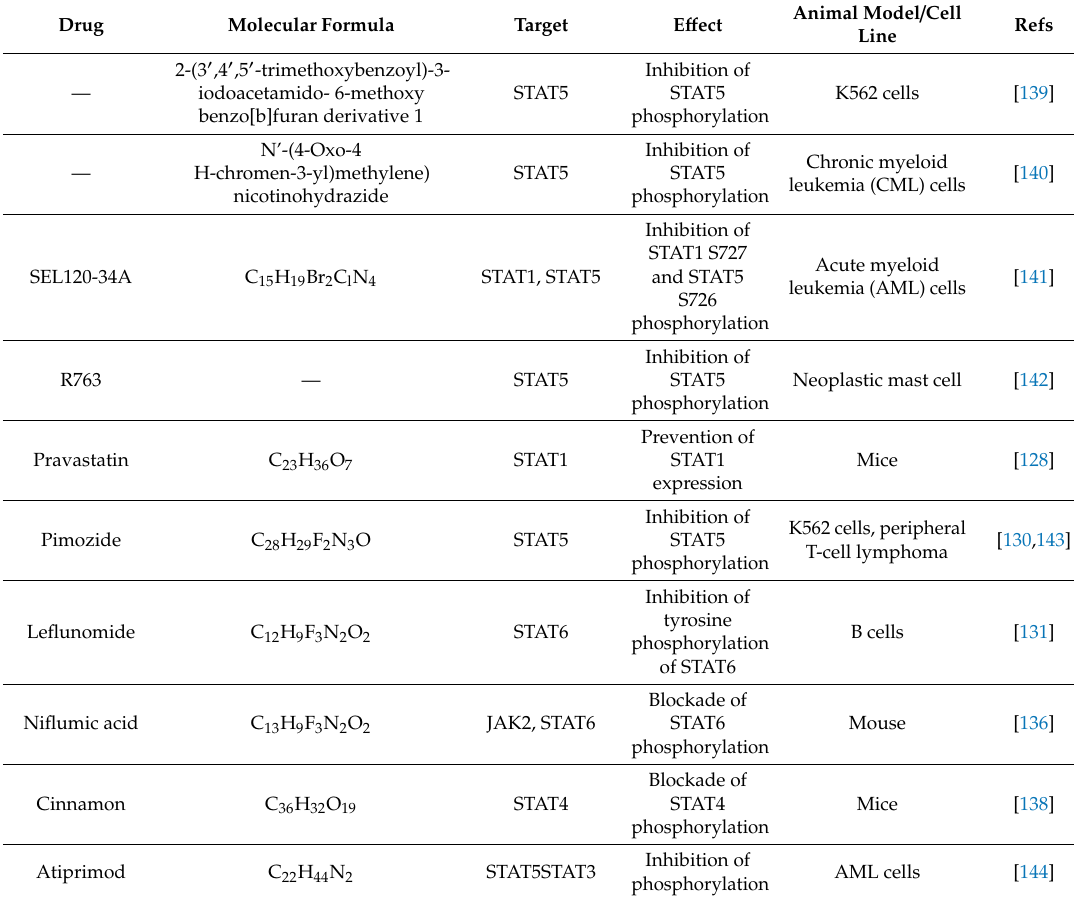
Table 1. Signal transducers and activator of transcription (STAT) inhibitors except STAT3